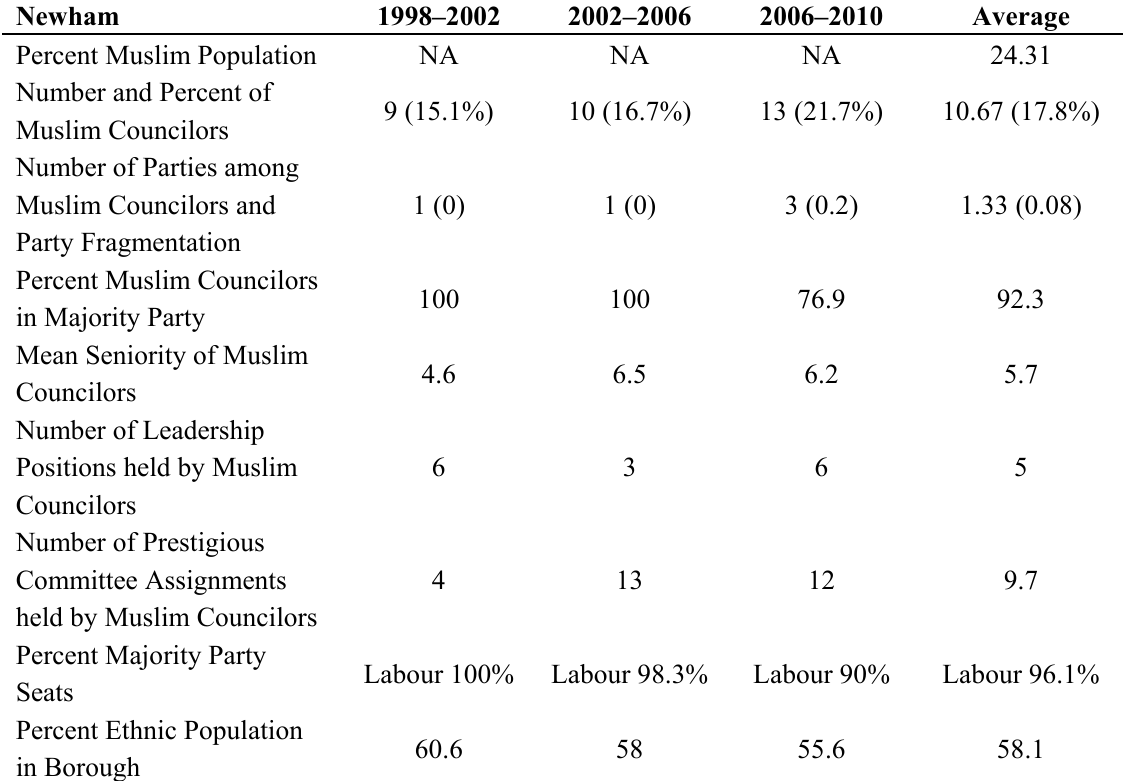
Table 2. Descriptive Statistics of Muslim Councilors in Newham.